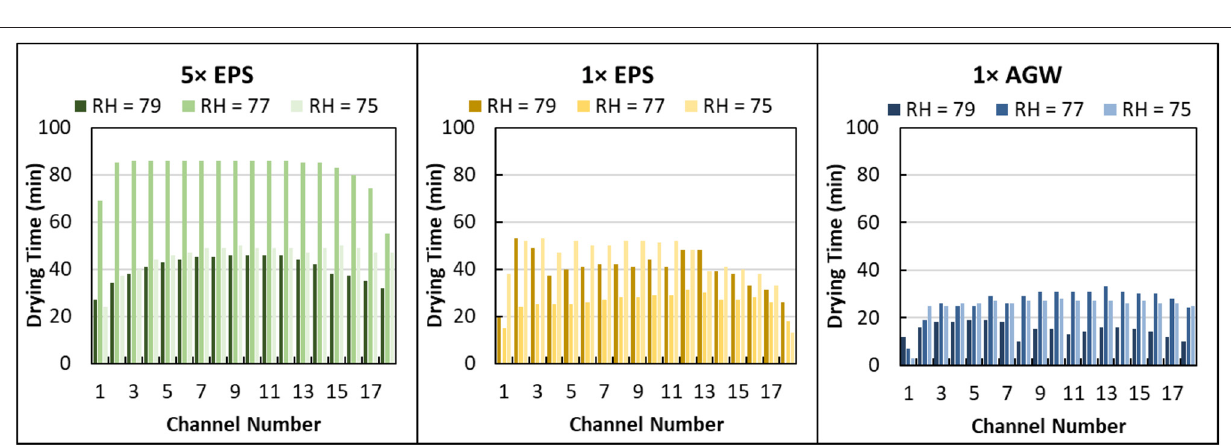
FIGURE 5 | Drying time distribution for different concentration extracellular polymeric substance (EPS) solutions suspended in artificial groundwater (AGW) in microcapillary arrays at different relative humidity (RH). Data are shown for 5 × EPS in 1 × AGW, 1 × EPS in 1 × AGW, and 1 × AGW (no EPS) at 79, 77, and 75%